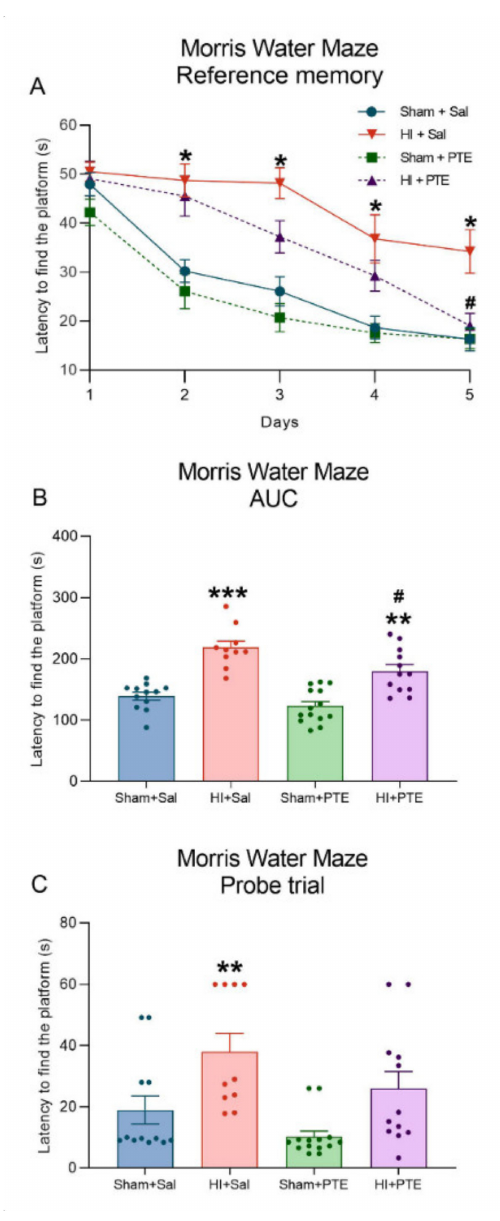
Figure 6. Reference spatial memory performance in the Morris Water Maze assessed at adult age. Data are expressed as mean ± SEM. Average latencies to reach platform during five consecutive days of training ( A ). Area under the curve of latency to find the platform during training ( B ). Latency to cross the platform location in the probe trial ( C ). * Injury effect (HI vs. control). # Treatment effect (Sal vs. PTE). Sham + Sal ( n = 12); HI + Sal ( n = 10); Sham + PTE ( n = 14); HI + PTE ( n = 12). Significance was accepted whenever p < 0.05 (* or #), p < 0.01 (** or ##), or p < 0.001 (*** or ###) (one-way